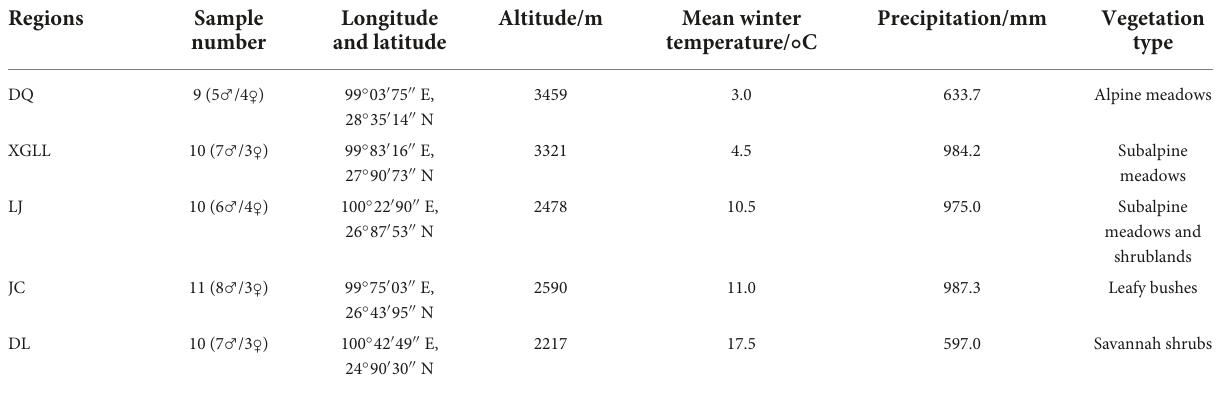
TABLE 1 Geographical locations and main conditions for five populations of Eothenomys miletus.